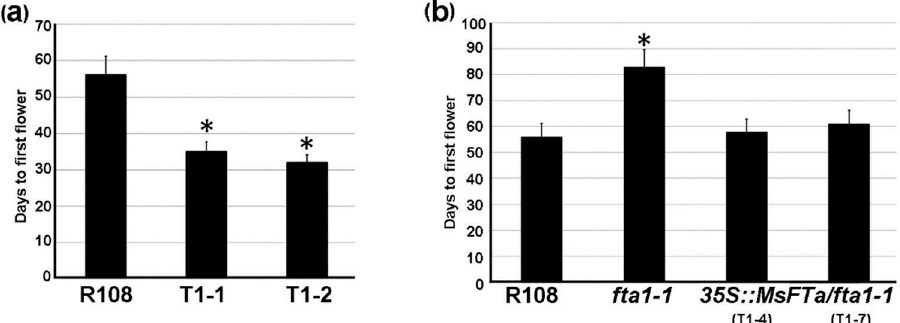
Figure 7. Ectopic expression of MsFTa in M. truncatula caused early flowering. ( a ) Comparison of flowering time between Medicago cv R108 overexpressing 35S::MsFTa (T1) and control (R108) plants under LD conditions. ( b ) Flowering time analysis of M. truncatula fta1-1 mutant (NF3307) plants ectopically expressing 35S::MsFTa (T1) under LD conditions. Flowering time was measured as days to the emergence of the first flower under LD conditions. Two independent lines for each transformation were analyzed. Data represent mean ± SD of three biological replicates. * indicates a significant di ff erence from wild type (Student’s t -test, p < 0.05).